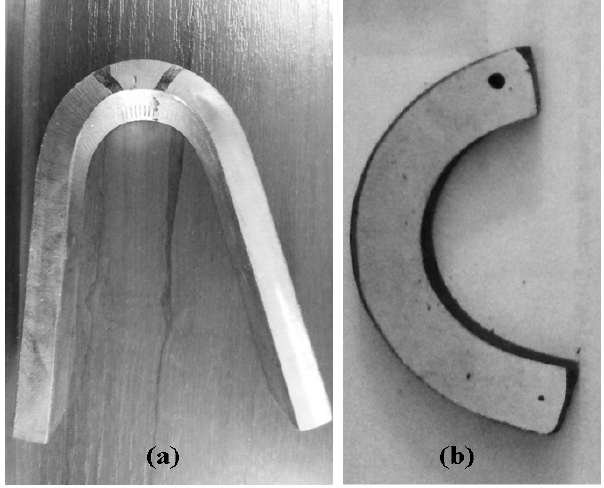
Figure 5. Tested samples: ( a ) sample EH36PAWJ after cross-bending with compressed root, ( b ) EH36PAWJ after sampling and surface grinding.